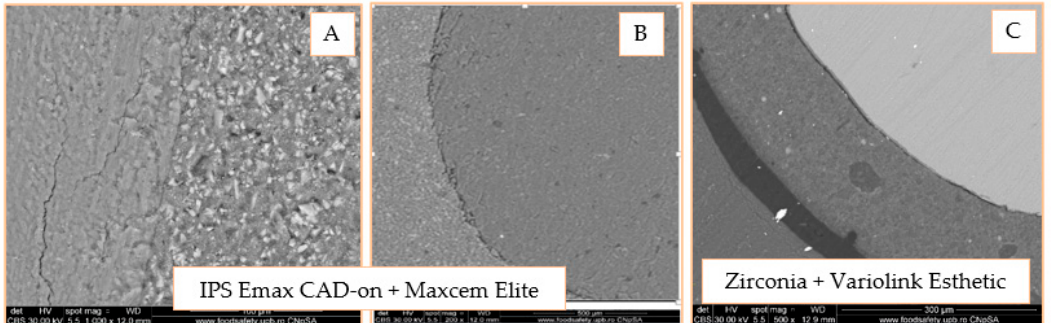
Figure 18. SEM 1000x image of the tooth area—adhesive cement ( A ); SEM 200× image of the IPS e.max adhesive cement- Figure 18. SEM 1000 × image of the tooth area—adhesive cement ( A ); SEM 200 × image of the IPS e.max adhesive cement- inlay area ( B ); SEM image, 500× of the enamel—adhesive system—adhesive cement—–inlay ( C ). inlay area ( B ); SEM image, 500 × of the enamel—adhesive system—adhesive cement—–inlay ( C ).